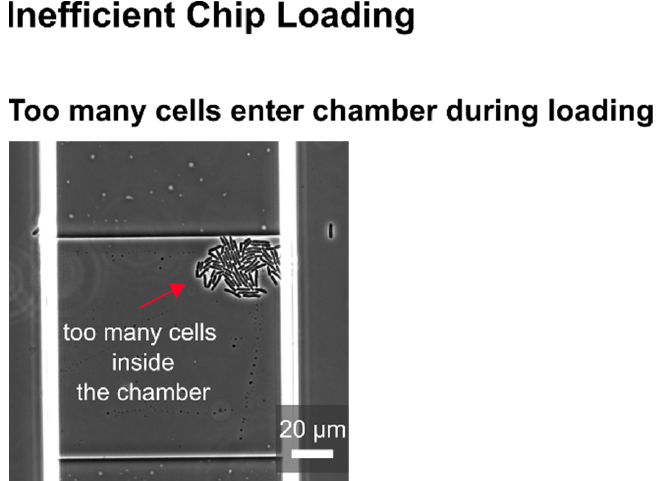
Figure A2. Example images of inefficient chip loading (see Table 3). Microscope images of too many cells enter chamber during loading.